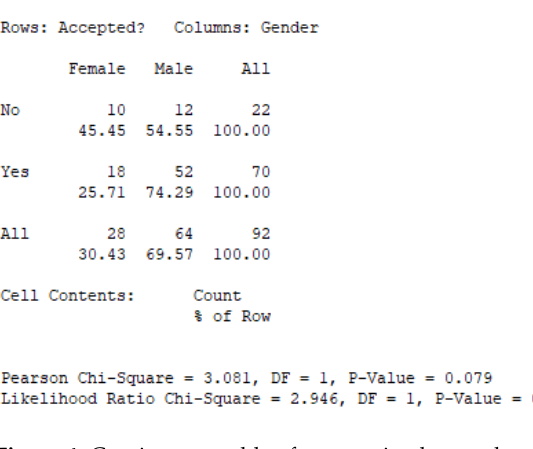
Figure 4. Contingency table of acceptation by gender.